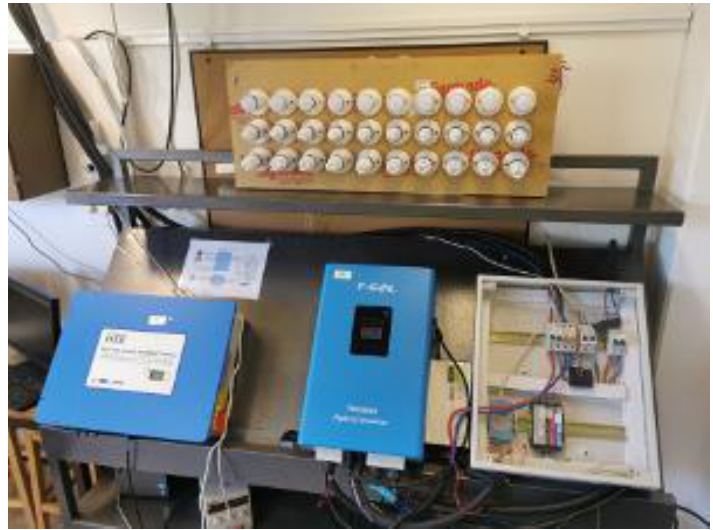
Figure 9. System implementation at the Smart Grid Lab. The top figure shows a block diagram of the system, while the bottom shows the actual implementation in the lab.